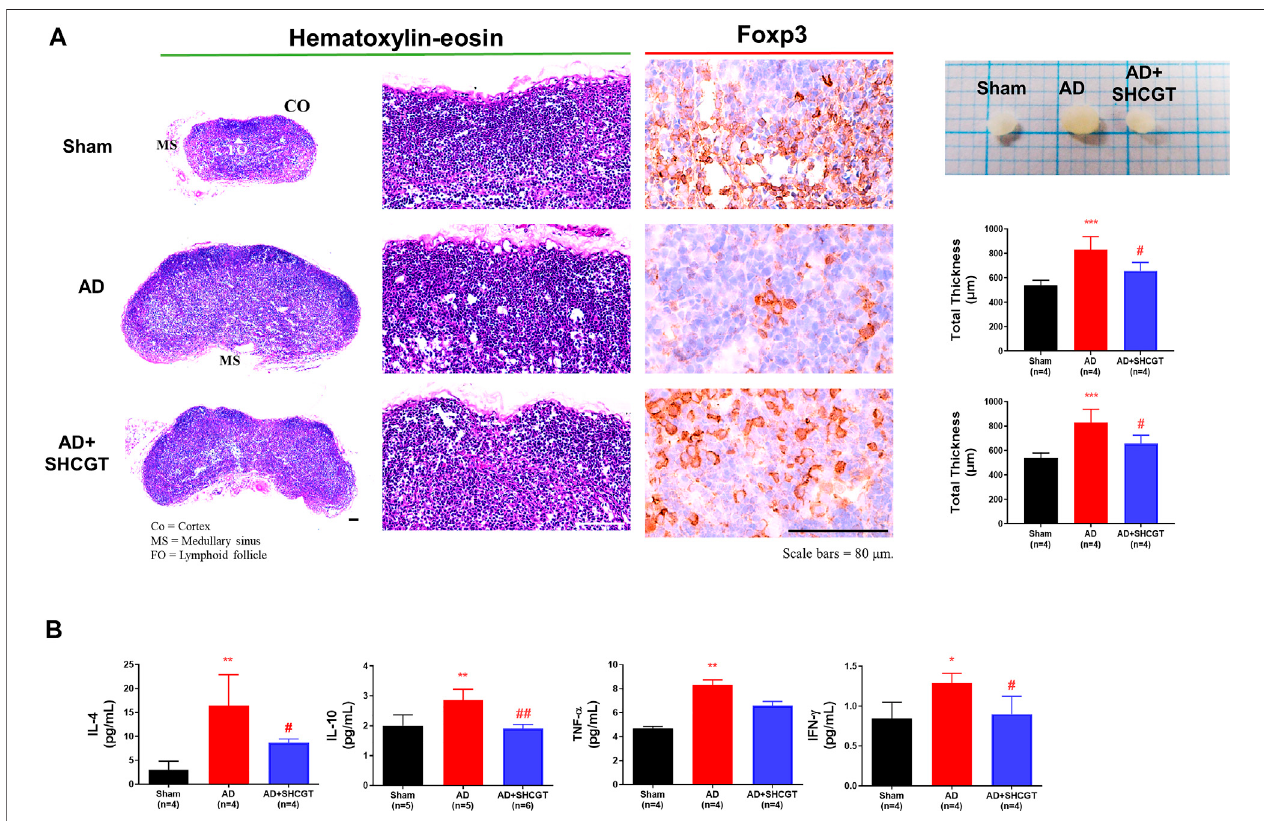
FIGURE 4 | SHCGT suppressed enlargement of peripheral lymph nodes and secretion of cytokines in the spleens of mice with DNCB-induced AD. (A) Immunohistochemical lymph node pro fi les showing that SHCGT reduced the marked hypertrophic changes in the expression of Foxp3, a marker of regulatory T-cell activity, in lymph node tissue from mice with DNCB-induced AD. (B) IL-4, IL-10, TNF- α , and IFN- γ levels in the spleen. Increased Th2 (IL-4 and IL-10)-related and Th1 (TNF- α and IFN- γ )-related cytokines were decreased by SHCGT in mice with AD. * p < 0.05, ** p < 0.01, *** p < 0.001 vs. sham; # p < 0.05, ## p < 0.01 vs. AD. AD, atopic dermatitis; CO, cortex; DNCB, 2,4-dinitrochlorobenzene; FO, lymphoid follicle; ICAM-1, intercellular adhesion molecule-1; IFN- γ , interferon-gamma; IL, interleukin; MS, medullary sinus; SHCGT, Sihocheonggan-Tang ; TNF- α , tumor necrosis